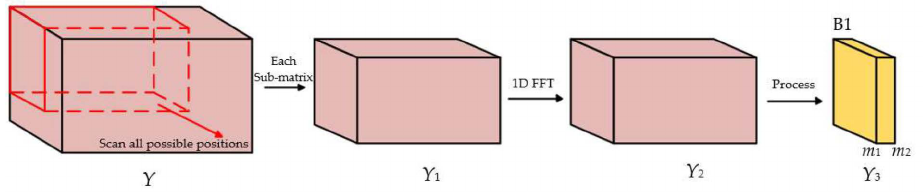
Figure 4. Frequency domain processing and spatial